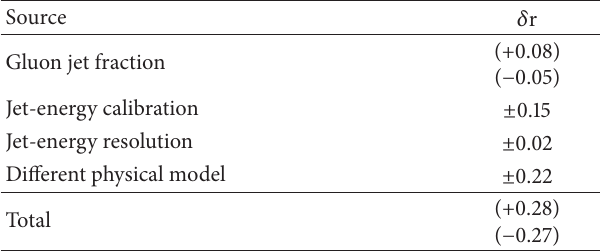
Table 6: Systematic uncertainties on ratio of subjet multiplicities from different